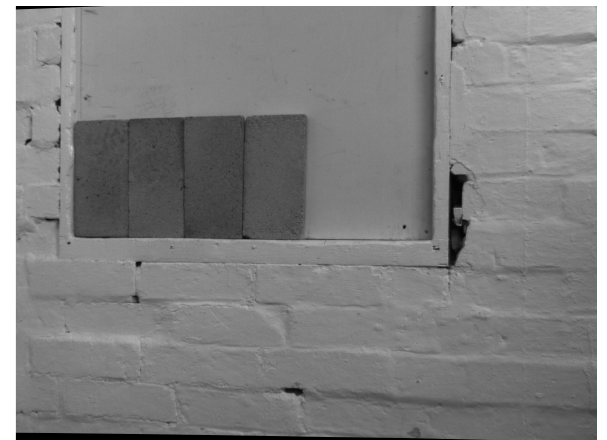
Figure 6 Example scene to be reconstructed. Left stereo image, epipolar rectified.